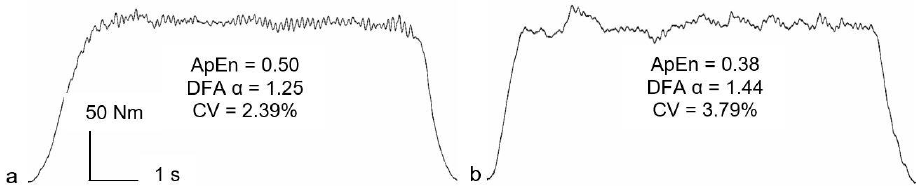
Figure 3. Raw output from a trial for a participant with different complexity and variability values on the right ( a ) and left ( b ) sides. Nm = Newton-meters; s = seconds; ApEn = approximate entropy; DFA α = detrended fluctuation analysis α; CV = coefficient of variation. ApEn right/left limb-symmetry-index = 131.6%; ApEn right/left absolute-asymmetry = 31.6%. DFA α right/left limb-symmetry-index = 86.8%; DFA α right/left absolute-asymmetry = 13.2%. CV right/left limb-symmetry-index = 63.1%; CV right/left absolute-asymmetry = 36.9%.